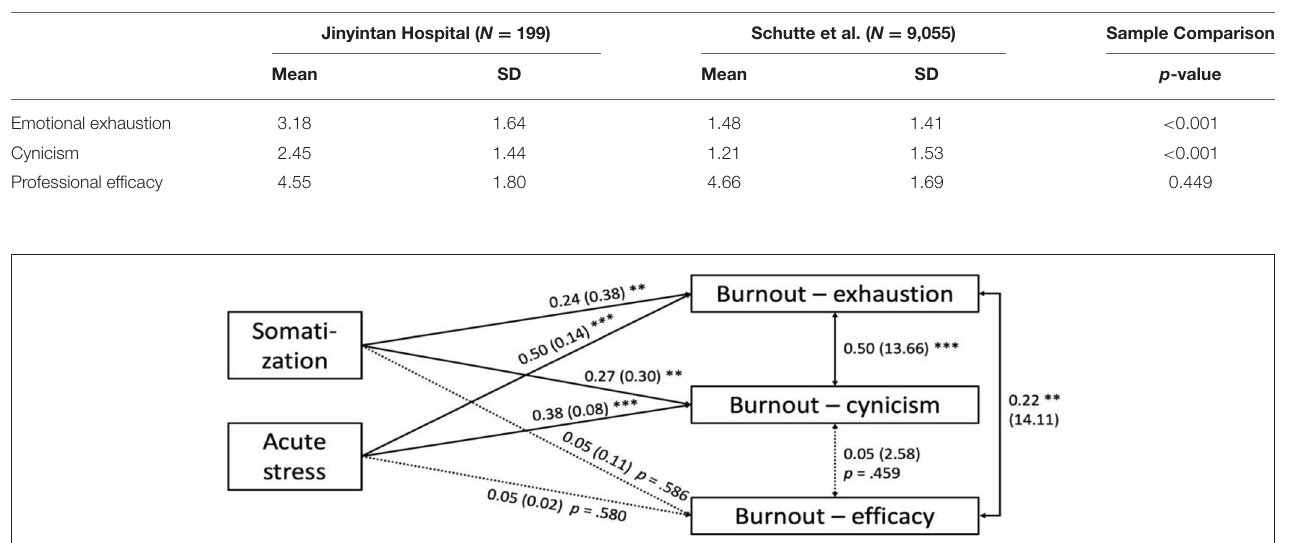
Frontiers in Psychiatry |